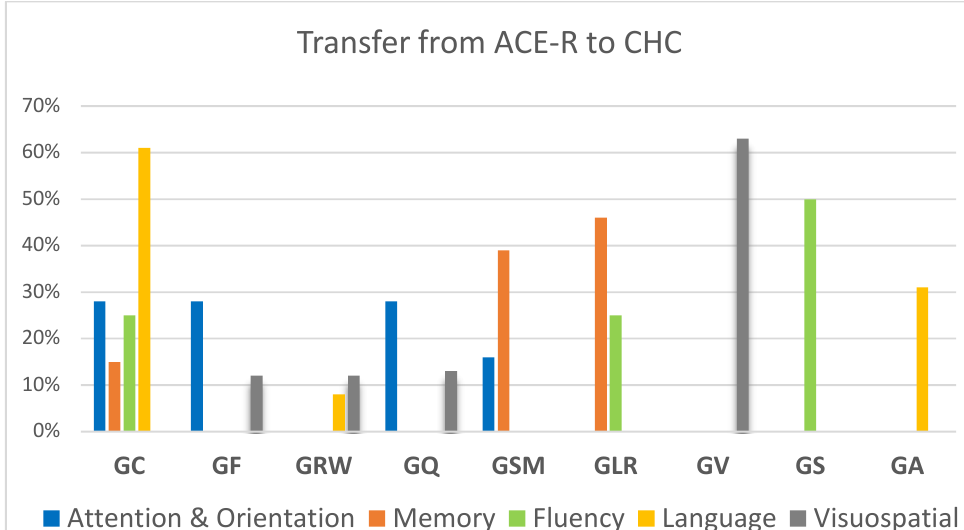
Figure 3. Transfer of the CHC domains according to the ACE-R factor analysis (Table 3). Table 3. Transfer of the CHC domains according to the modified ACE-R factor analysis.